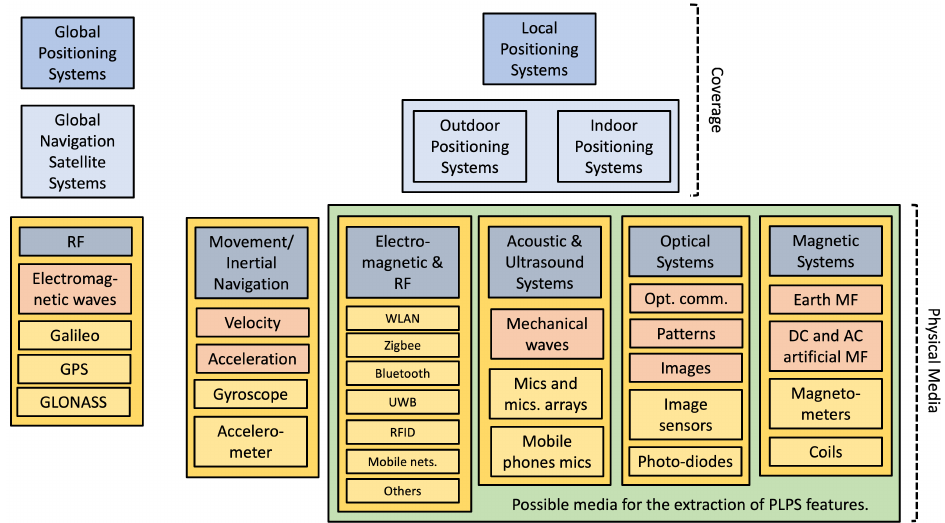
Figure 1. Schematic view of systems and physical quantities used for positioning. Some systems are specially designed for positioning, such as the GPS, while others opportunistically employ legacy sys- tems for positioning. The latter may rely on artificial or nature-born information. The green rectangle indicates the possibilities for PLPS construction—the characteristics, technologies, and applications for PLPS are the subject of this